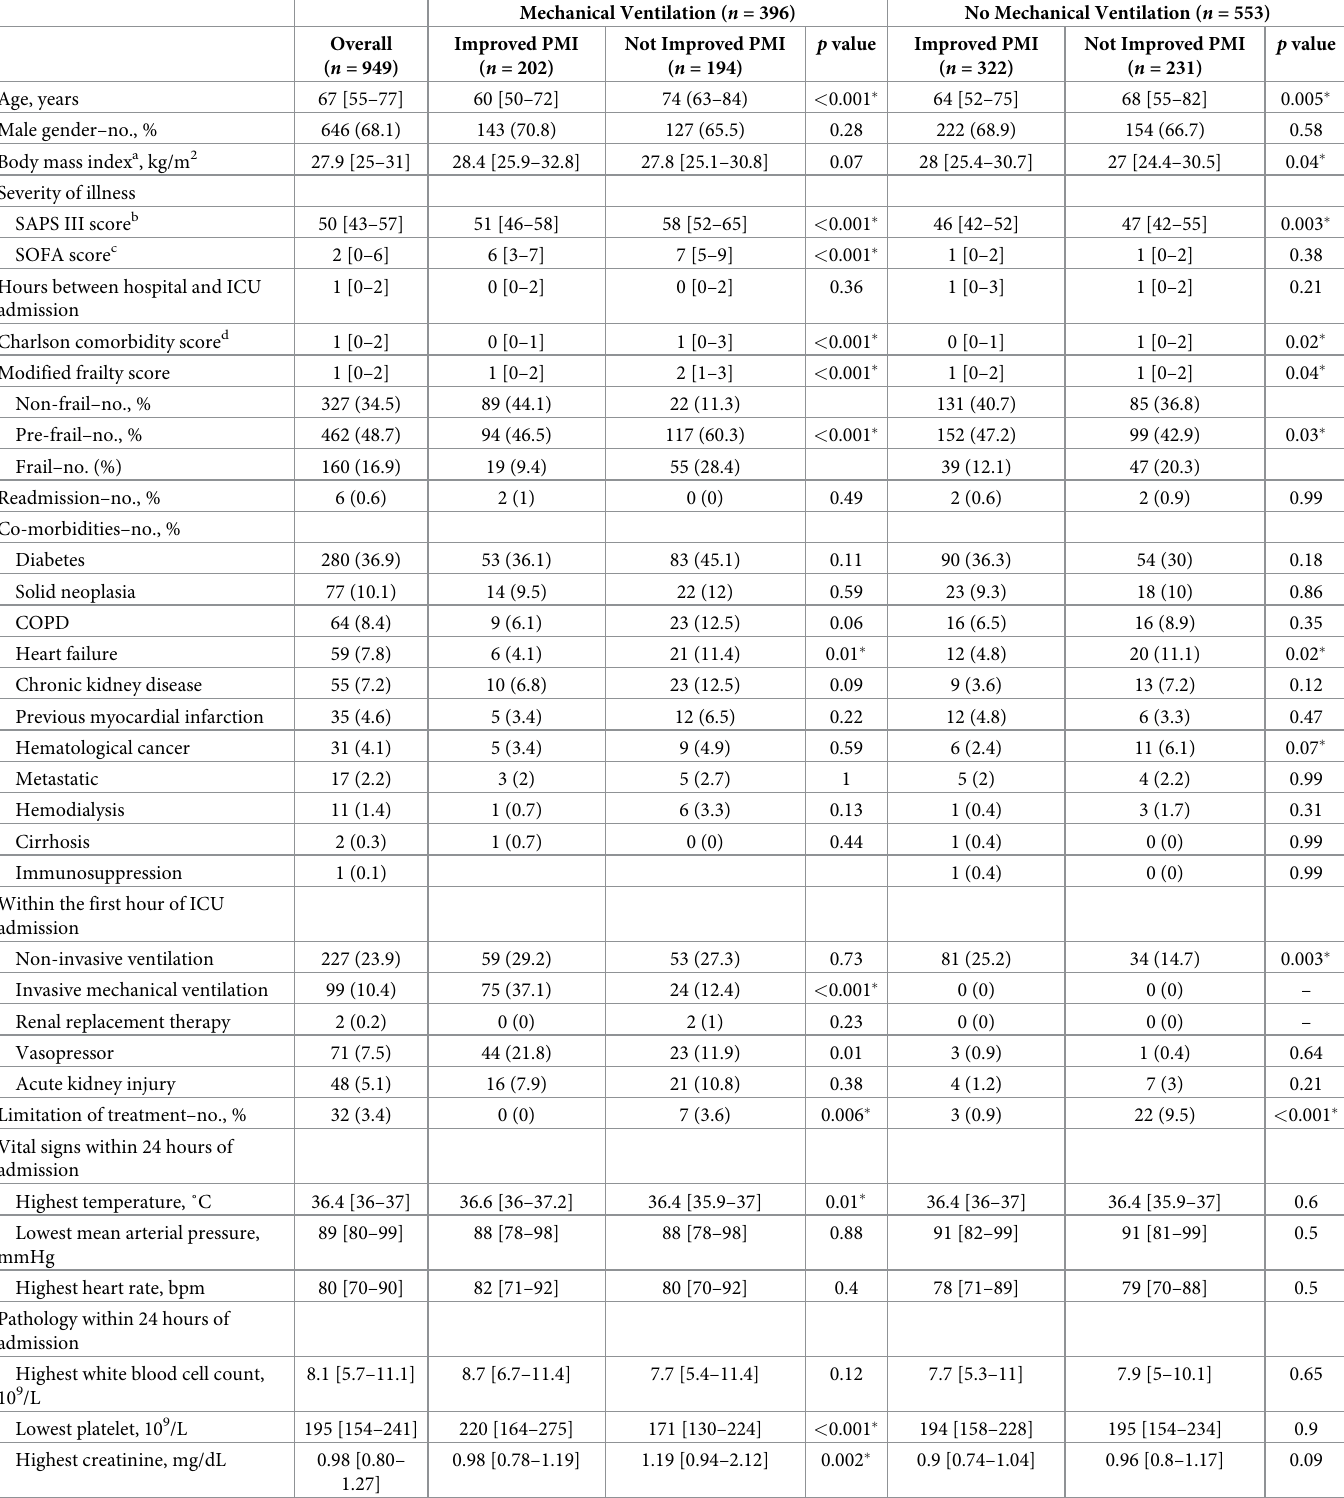
Table 1. Baseline characteristics and clinical outcomes of the included